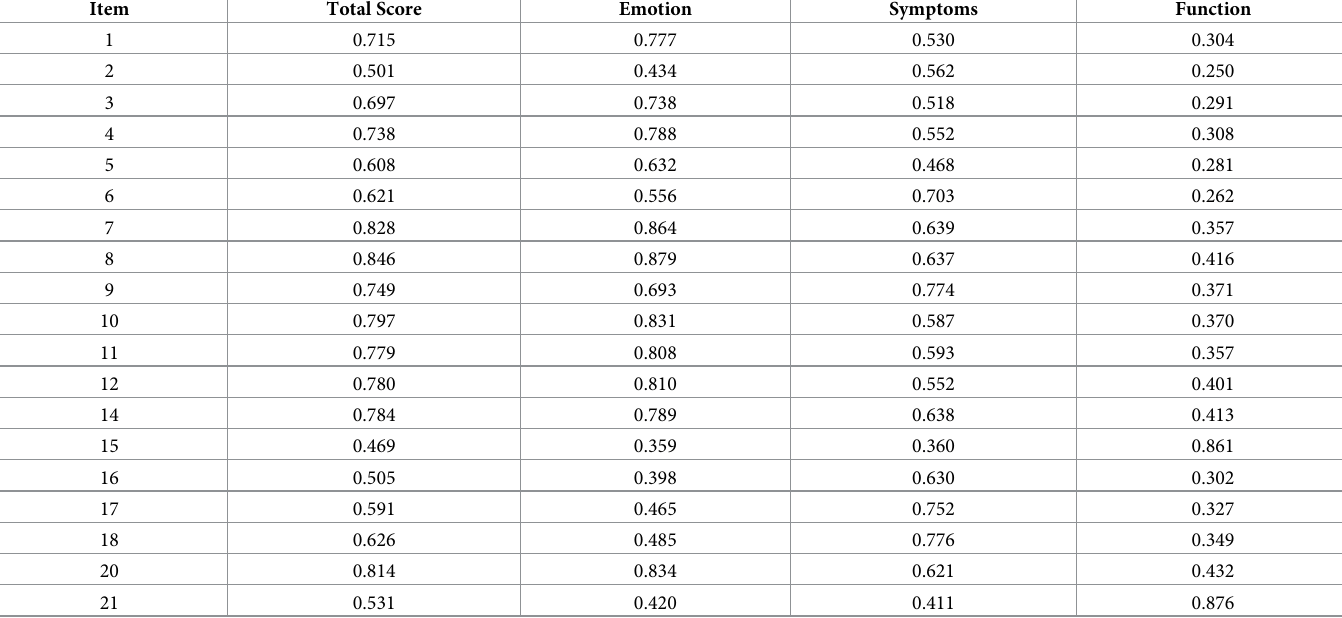
Table 7. Construct validity for individual items of the adjusted RosQol (n = 265).